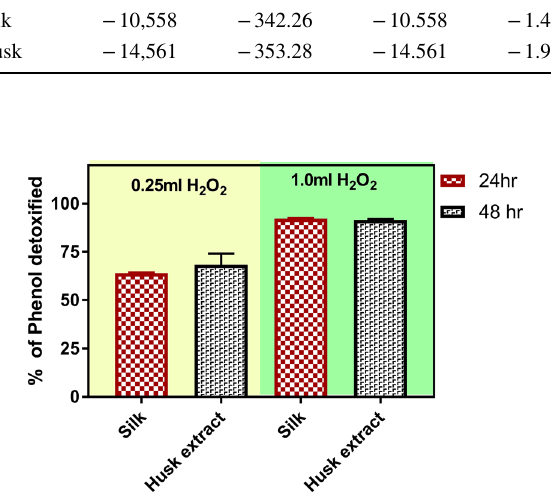
Fig. 11 Percentage detoxification